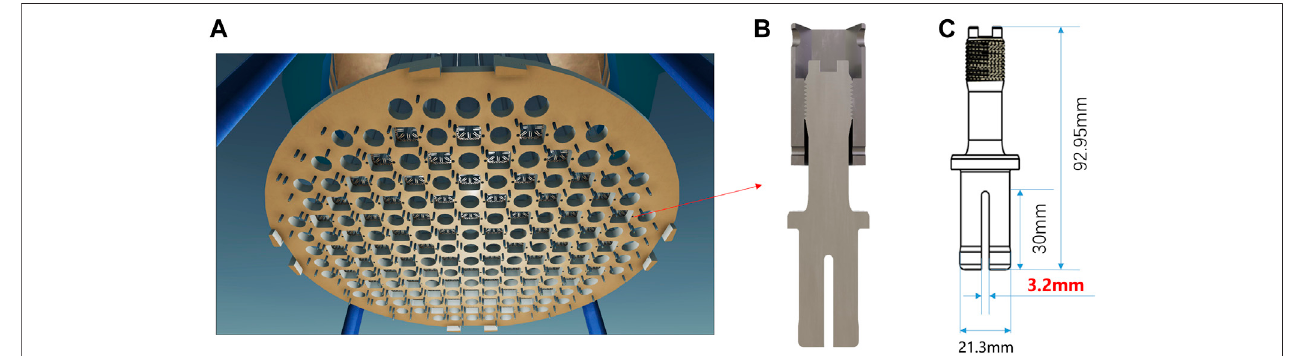
FIGURE 1 | Structure of the split pin: (A) postion of the split pin; (B) cross section; (C)